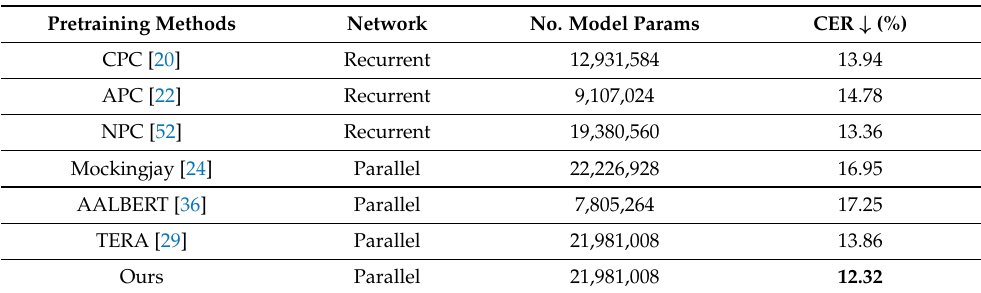
Table 5. Comparison of ASR performance based on different pretrained methods. All the counter- parts are pretrained with KsponSpeech-SVR1K with S3PRL Toolkit settings. Recurrent and Parallel represent using RNN or Transformer-based neural networks for pretraining, respectively. Bold indicates the best performance.